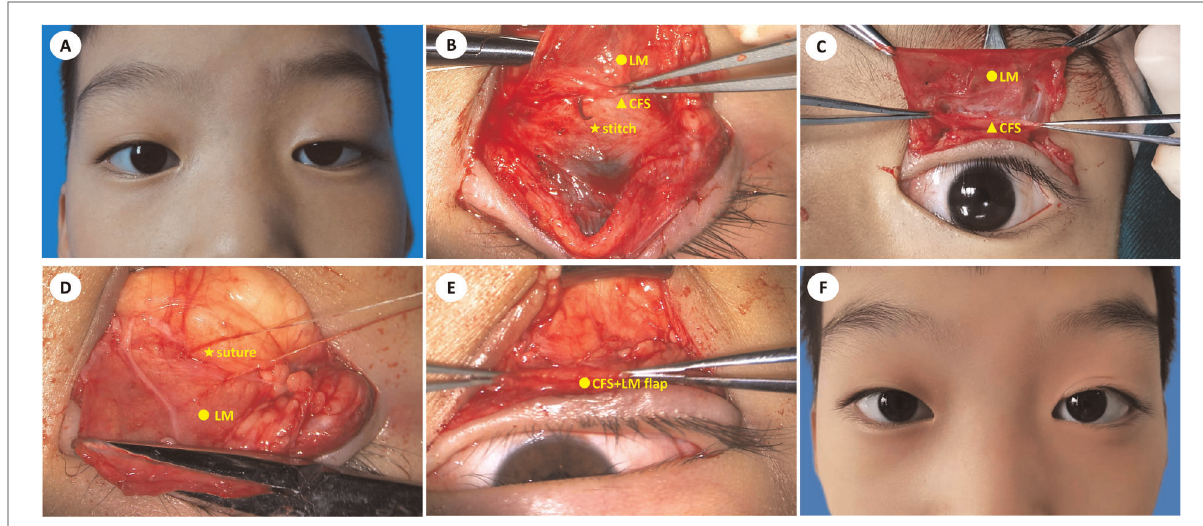
FIGURE 1 An 8-year-old boy with congenital ptosis (OS) treated by modi fi ed CFS suspension under general anesthesia. ( A ) preoperative image; ( B ) suturing CFS and LM with 5-0 absorbable stitches; ( C ) exposure of CFS and LM; ( D ) using mattress sutures to fi x CFS+LM complex fl ap onto the tarsus; ( E ) exposure of the CFS+LM complex fl ap; ( F ) twelve months after CFS+LM